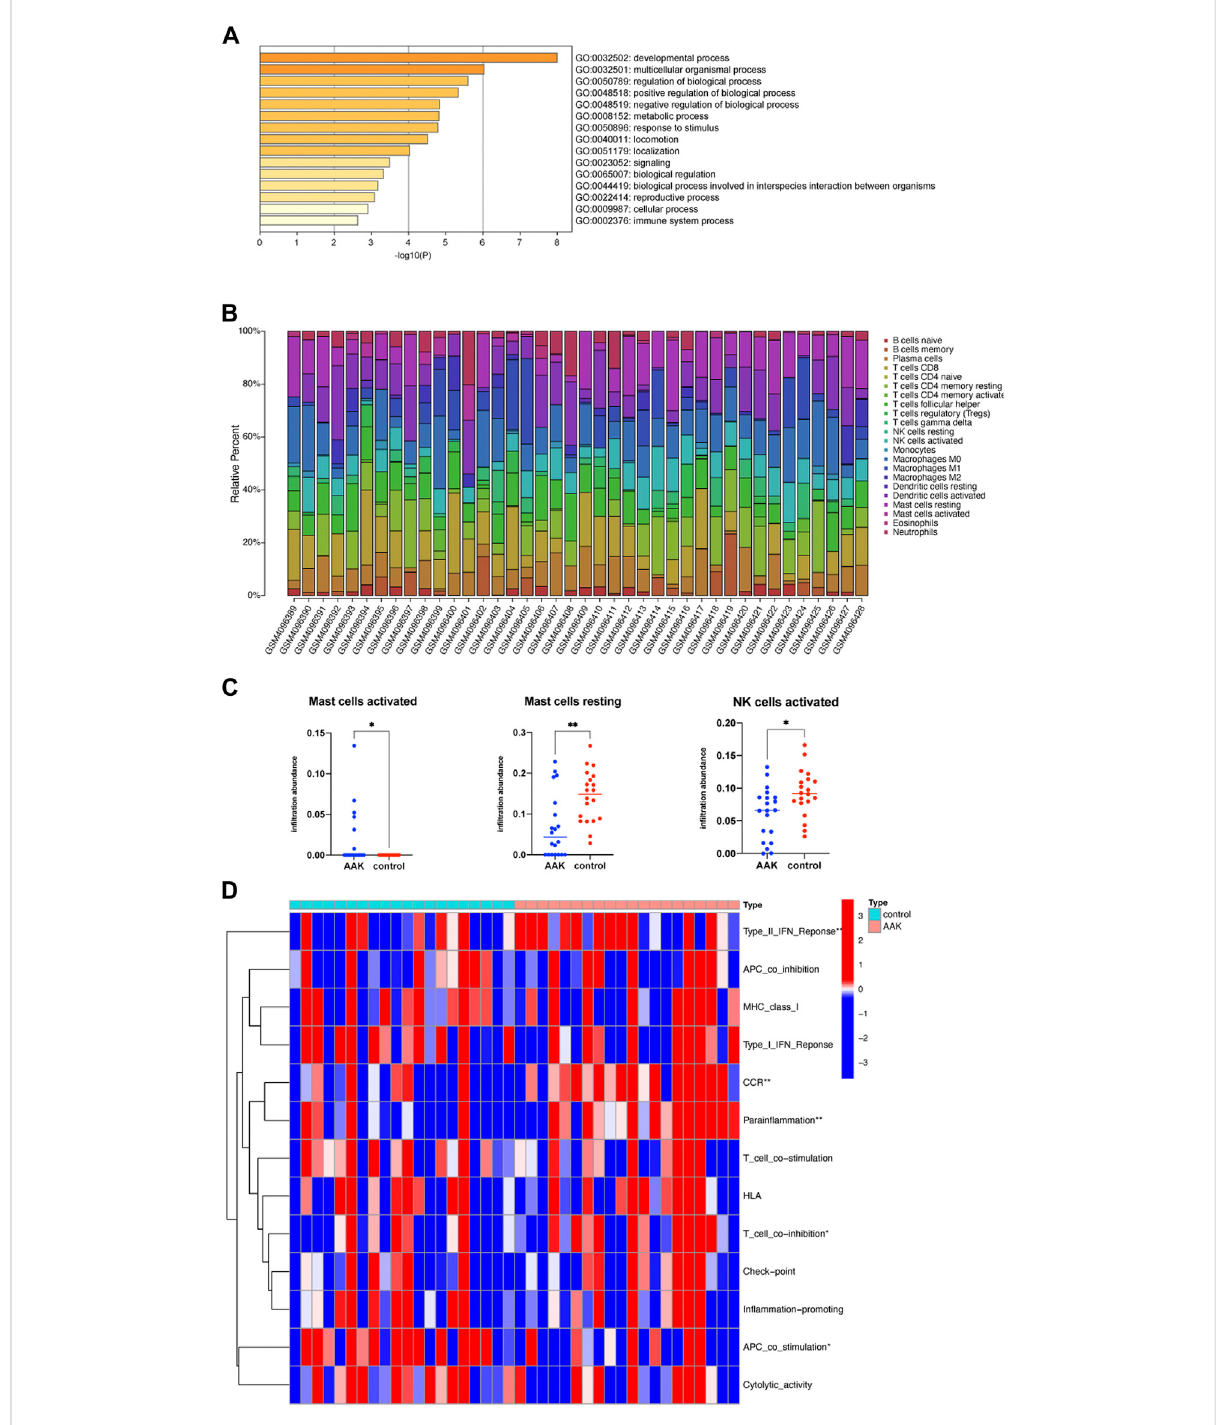
FIGURE 7 Immune function analysis. (A) GO enrichment of ceRNA-related genes, involving the immune system process. (B) CIBERSORTX immune cell in fi ltratesanalysis.Thepercentageof22typesofimmunecellsineachsample. (C) ActivatedMastcellsweremorebutrestingmastcellsandactivated NK cells were less in the AAK group. (D) Further analysis of immune function based on the ssGSEA indicated that Type II INF Response, CCR, parain fl ammation, T cell co-stimulation, and APC co-stimulation were different between the two groups. * p < 0.05, ** p < 0.01; *** p <